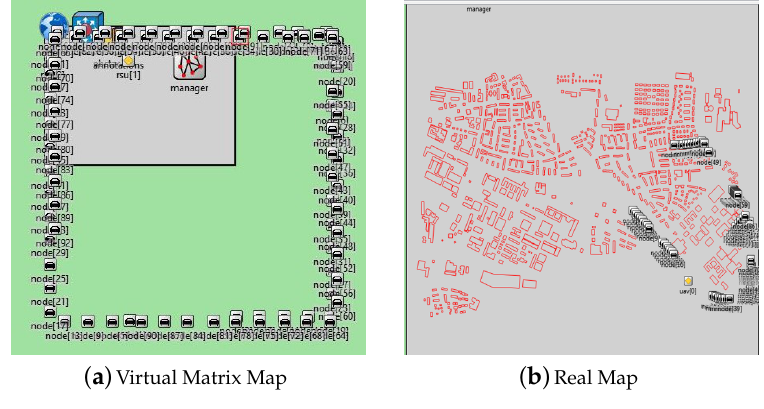
Figure 7. Simulation